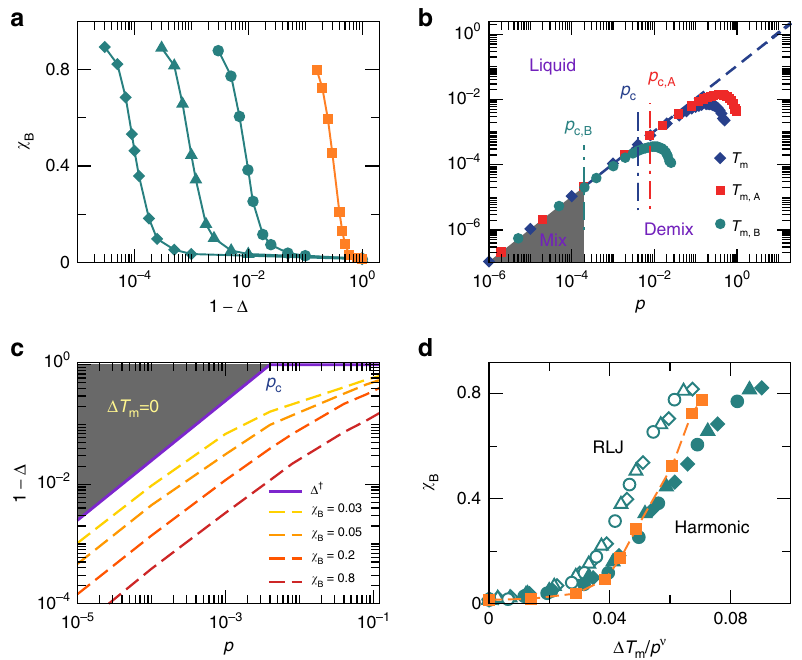
Fig. 3 Effects of particle stiffness. Here we show results for γ = 1 and c B = 0.5 systems with the variation of Δ at ~ κ ¼ 1 : 22 ´ 10 (cid:2) 6 . a Evolution of χ B with Δ in solid-like states for harmonic systems at p = 10 − 5 (diamonds), 10 − 4 (triangles), 10 − 3 (circles), and 0.12 (squares). The lines are guides for the eye. Curves in dark green are in the pressure regime of p < p c as de fi ned in b , where T m ( p ) is linear. The orange curve is at p > p c where T m ( p ) is nonlinear. b Phase diagram in the temperature and pressure plane for harmonic systems with Δ = 0.95. The diamonds, squares, and circles are melting temperature curves T m ( p ), T m,A ( p ), and T m,B ( p ), respectively. The dashed line shows the linear behavior. The vertical dot-dashed lines label p c,B , p c , and p c,A , at which the melting temperature curves deviate from linear by 5%. The gray area below melting temperatures and to the left of p = p c,B is where the system can mix well (labeled by “ mix ” ). The area below melting temperatures and to the right of p = p c,B is where A and B particles tend to demix (labeled by “ demix ” ). Above melting temperatures are liquids. c Crossover Δ † ( p ) (solid line) and the iso- χ B contours (dashed lines) for harmonic systems. The gray area is Δ ≤ Δ † , where Δ T = 0. d Scaling collapse of χ Δ T p = 10 − 5 (diamonds), 10 − 4 (triangles), and 10 − 3 (circles) for harmonic (solid) and RLJ (empty) m B ( m ) at systems, with ν ≈ 1.02. The squares with a dashed line show the deviation from the master curve at p = 0.12 > p c for harmonic